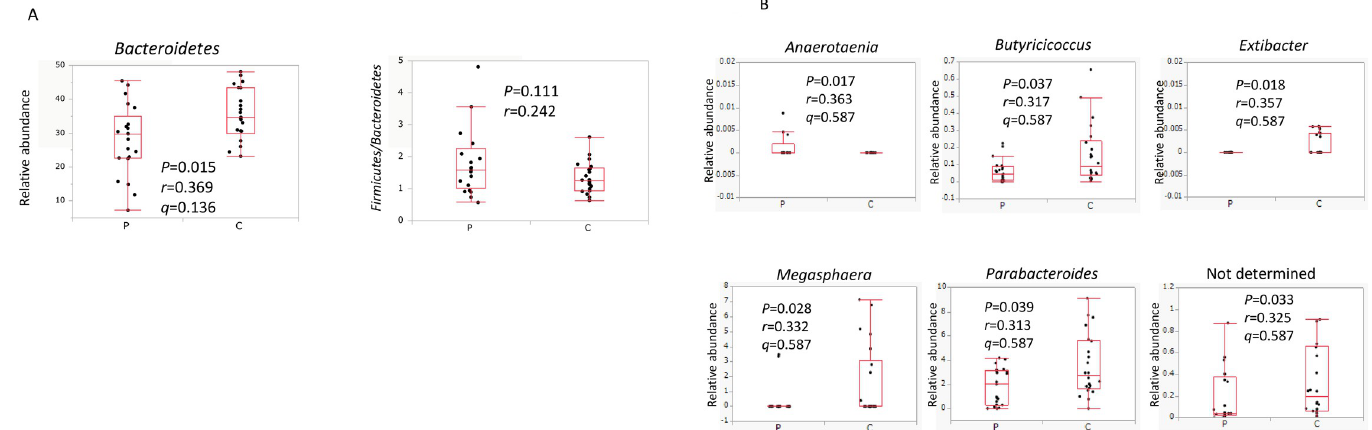
Fig 3. Comparison of the gut microbiotas between the PMDs group and the control group. The relative abundance of each taxon in the gut microbiota was compared. (A) At the phylum level, only Bacteroidetes was significantly less abundant in the PMDs group than in the control group. (B) The abundance of genus-level bacteria was significantly different between the PMDs group and the control group. The Wilcoxon signed-rank test was used to compare differences between the two groups ( P < 0.05). Abbreviations: PMDs, premenstrual disorders; P, premenstrual disorders group; C, control group.